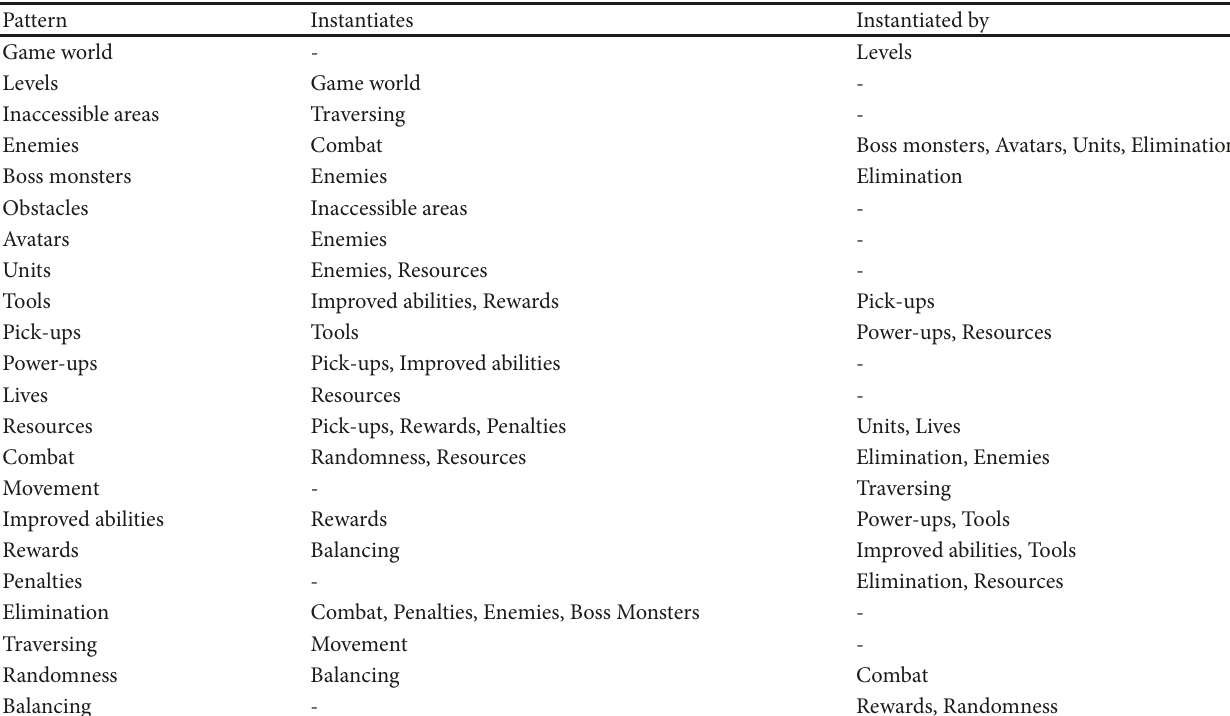
Table 1: Patterns in game design and their